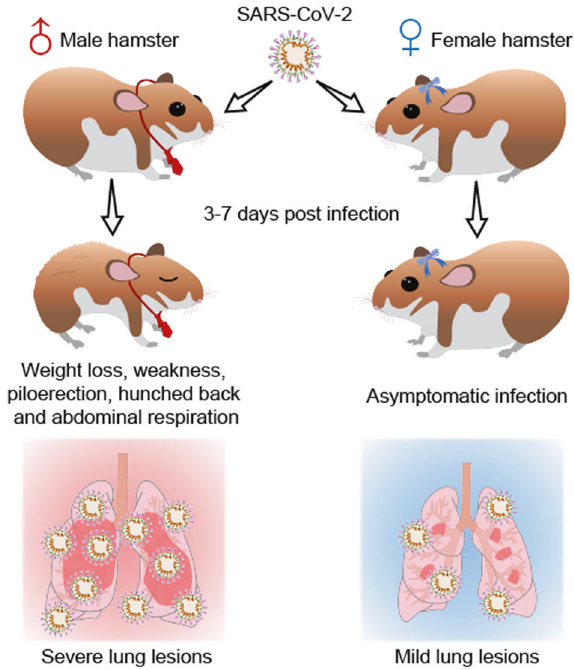
Fig. 5 Schematic summary of the male gender bias of SARS-CoV-2 infection in hamster Signal Transduction and Targeted Therapy (2021)